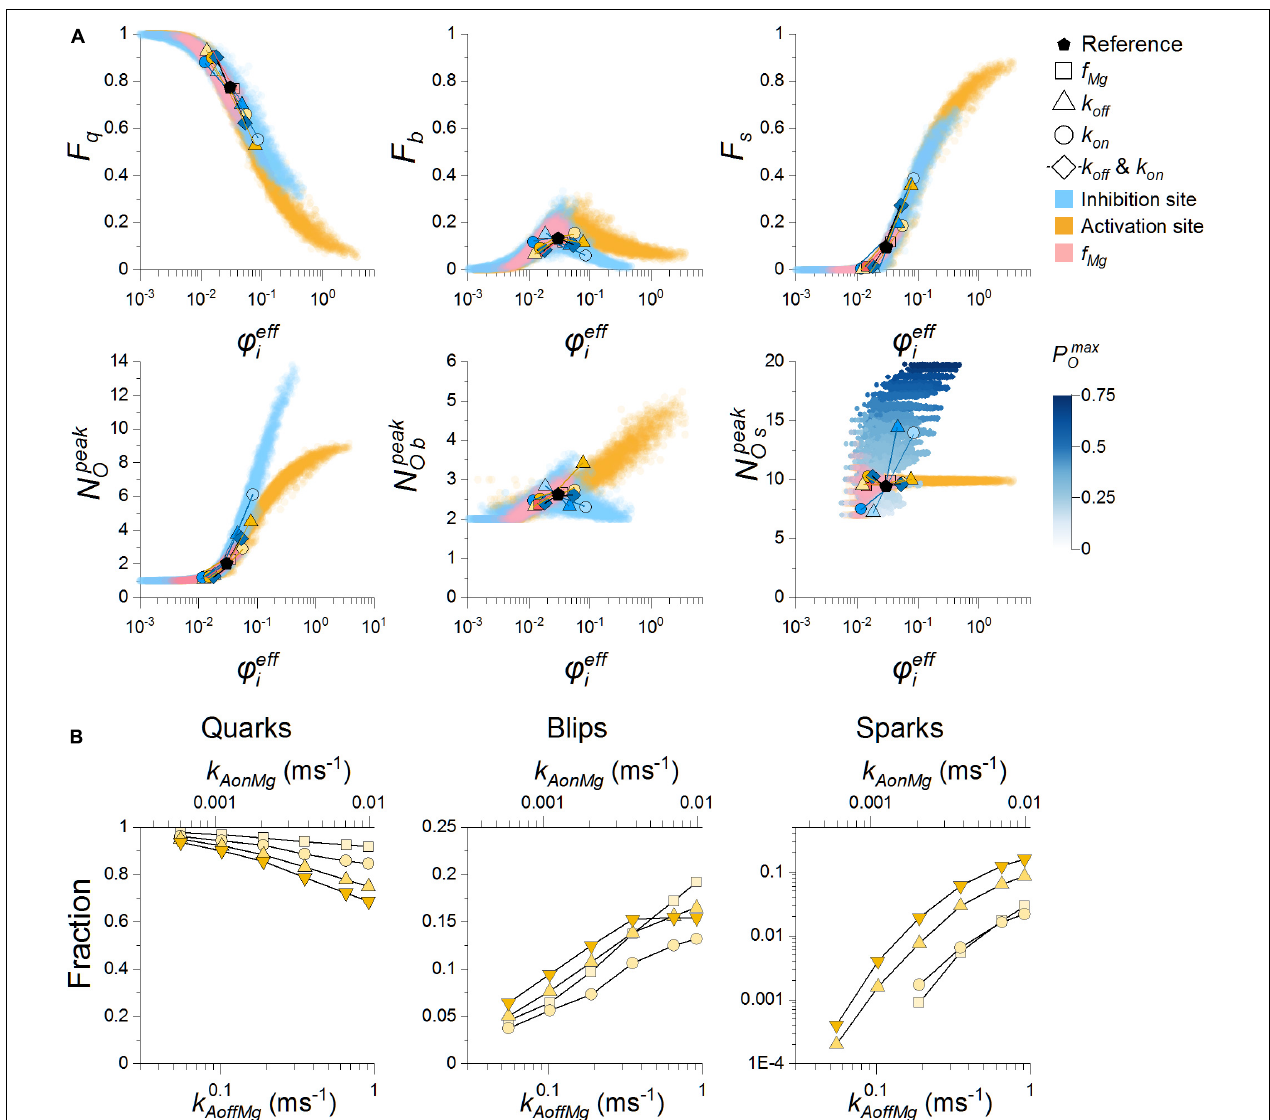
FIGURE 7 | Calcium release event characteristics related to the effective coupling strength. (A) The whole dataset (14240 points per panel) for various Mg-binding parameters of the RyR activation site (orange and pink) and the RyR inhibition site (blue), which were obtained for all RyR vicinities and all single-channel calcium currents (not indicated). The dots are semitransparent to better visualize the data. The circles, triangles, and diamonds mark results for decreased ( × 0.5; lighter color) or increased ( × 2; darker color) Mg-binding parameter values (see legend), relative to the reference parameter values (black pentagons). The P max O colormap refers solely to the N peak OS graph to indicate the relation of the N peak OS increase to P max O increase when varying Mg-binding at the inhibitory site, not present in the case of blips. (B) The dependence of the fraction of quarks, blips, and sparks on the reciprocally changed rate constants k AonMg (top axis) and k AoffMg (bottom axis), so that the equilibrium constant K AMg stayed at the reference value of 92 µ M. Squares, circles, up triangles and down triangles denote values of i Ca = 0.15, 0.25, 0.4, and 0.6 pA,